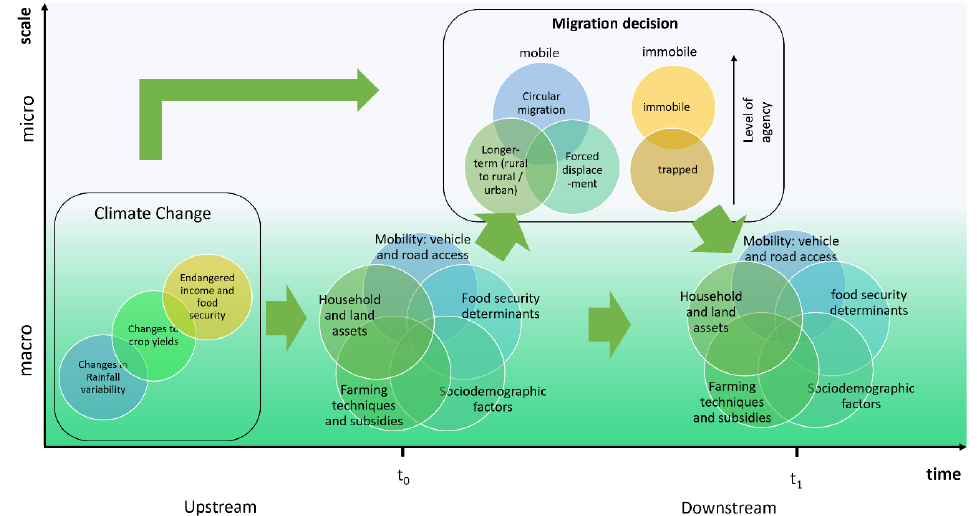
Figure 2. A conceptual model exploring the relationship between climate change and migration in the context of Malawi.